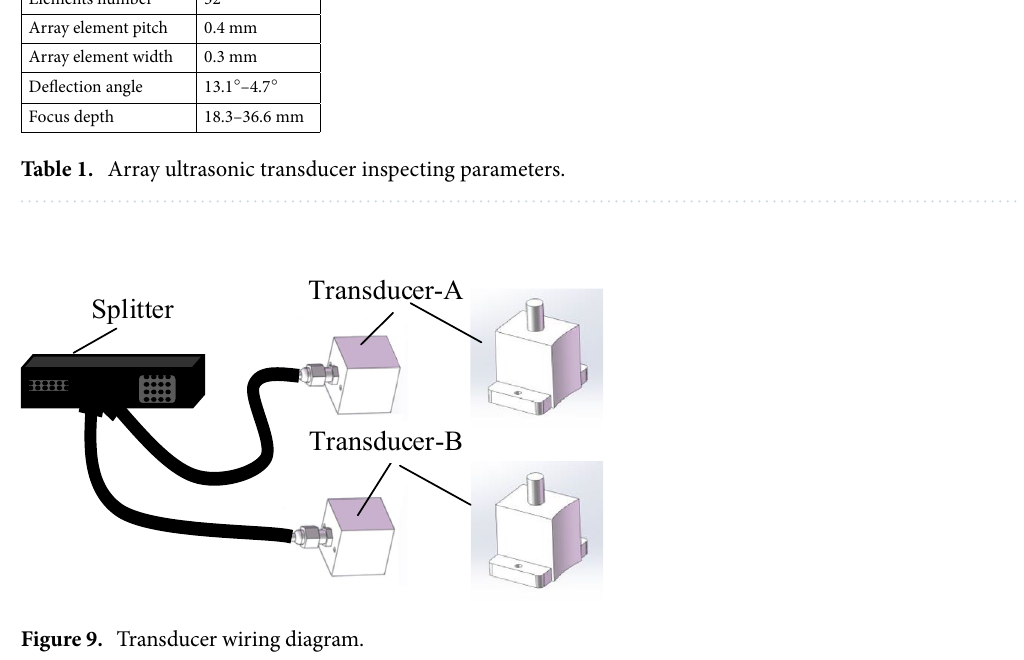
Figure 9. Transducer wiring